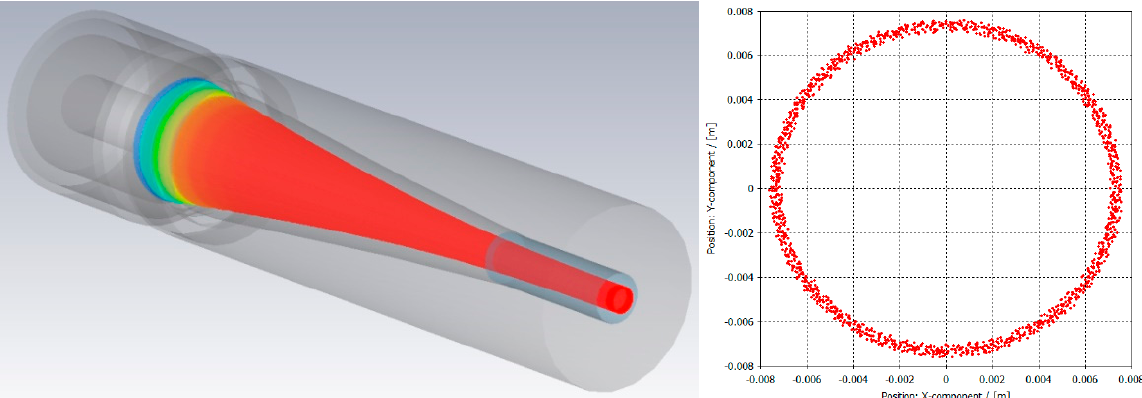
Figure 7. Trajectory of the electron beam simulated by CST. In the right image, a thickness of 0.4 mm can be observed for the electron beam injected into the resonator.